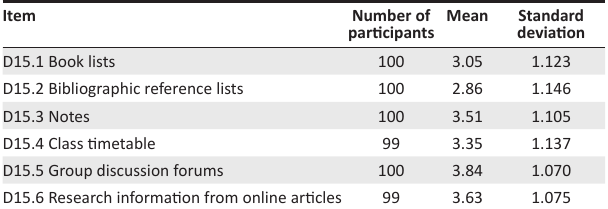
TABLE 3: Descriptive statistics for coursework information most frequently accessed and shared.